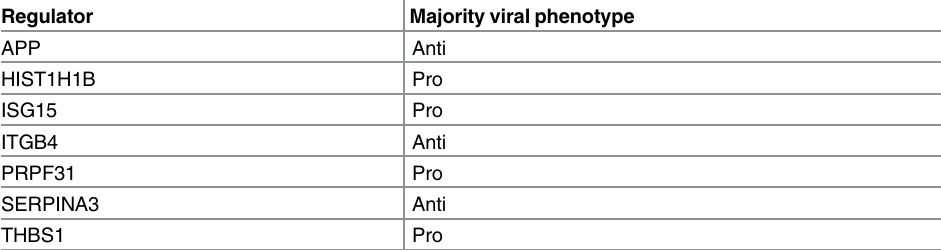
THBS1 Pro Four siRNAs were used per gene. All genes had multiple siRNAs with signi fi cant effects, and all had at least one at least ten-fold. However, for most genes, different siRNAs resulted in different effects on virus titer; therefore we characterize each by its majority viral phenotype among the signi fi cant siRNAs. Full data and results are available in S7 Table